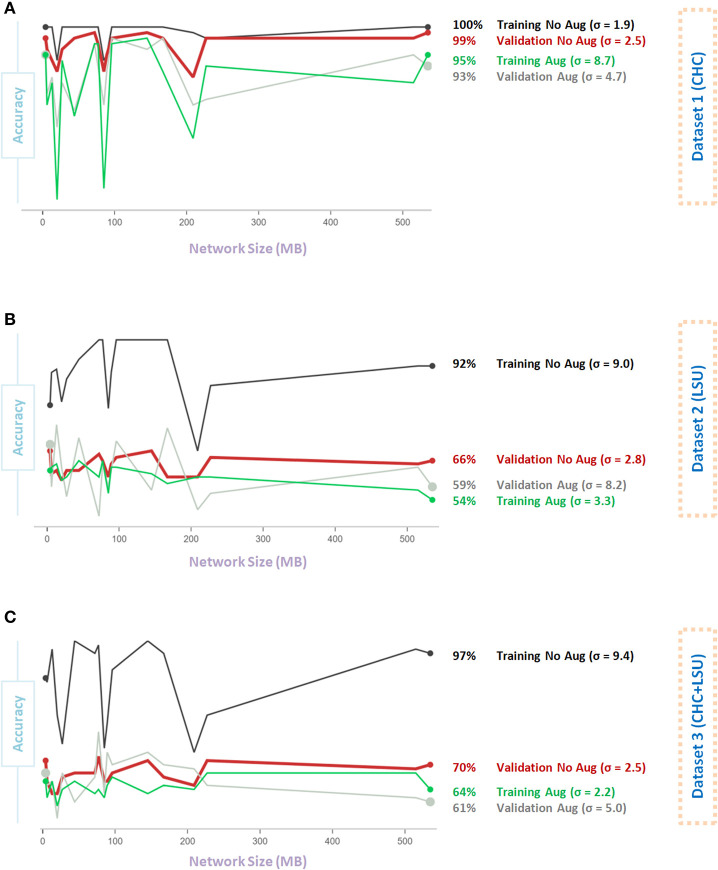
Effect of network size on Data Augmentation 2 (22) for detecting X-ray images with and without COVID-19. (A) CHC Dataset. (B) LSU Dataset. (C) CHC+LSU Dataset. Here, σ refers to standard deviation of performance with respect to network size, which is calculated to measure stability over different network sizes, high value means less stability.